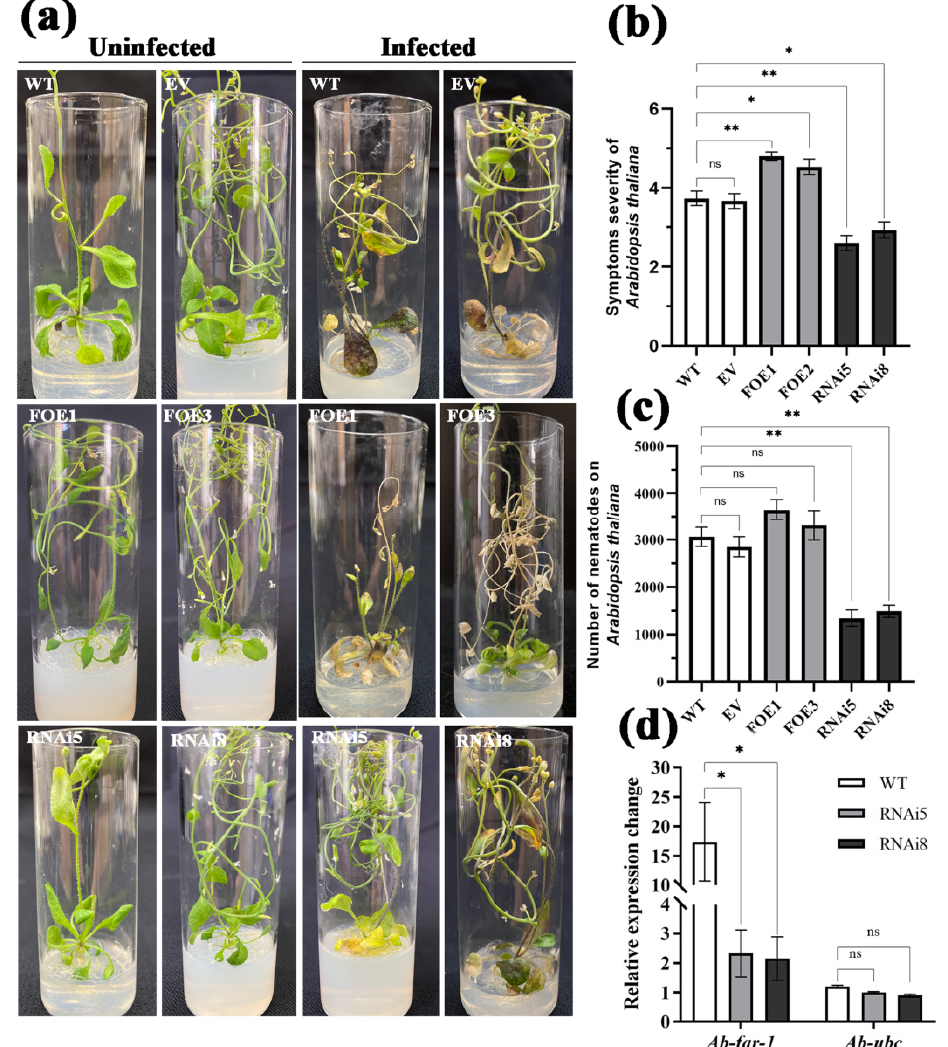
Figure 5. Investigation of Aphelenchoides besseyi parasitism on Ab-FAR-1 Δ sp overexpressing (OE) and Ab-far-1 silencing (RNAi) Arabidopsis thaliana . ( a ) Symptoms of damage in various A. thaliana lines. ( b ) The symptom severity in various A. thaliana lines. ( c ) The total numbers of nematodes were counted in various A. thaliana lines. These data of Ab-FAR-1 Δ sp overexpressing line 1# (FOE1) and 3# (FOE3), Ab-far-1 silencing line 5# (RNAi5) and 8# (RNAi8), empty vector transgenic line (EV) and their wild types (WT) were recorded at 21 days post inoculation (dpi) with A. besseyi. Values are indicated as the means ± SE, n = 15. ( d ) The Ab-far-1 gene was silenced in A. besseyi collected from A. thaliana RNAi lines. The Ab-18S gene was used as an internal reference gene. The expression levels of Ab-ubc from A. besseyi were used to determine the specificity of the Ab-far-1 -targeting RNAi. Values are means ± SE, n = 3. Asterisks denote significant differences (* p < 0.05, ** p < 0.01; t -test). There were three independent biological replicates.